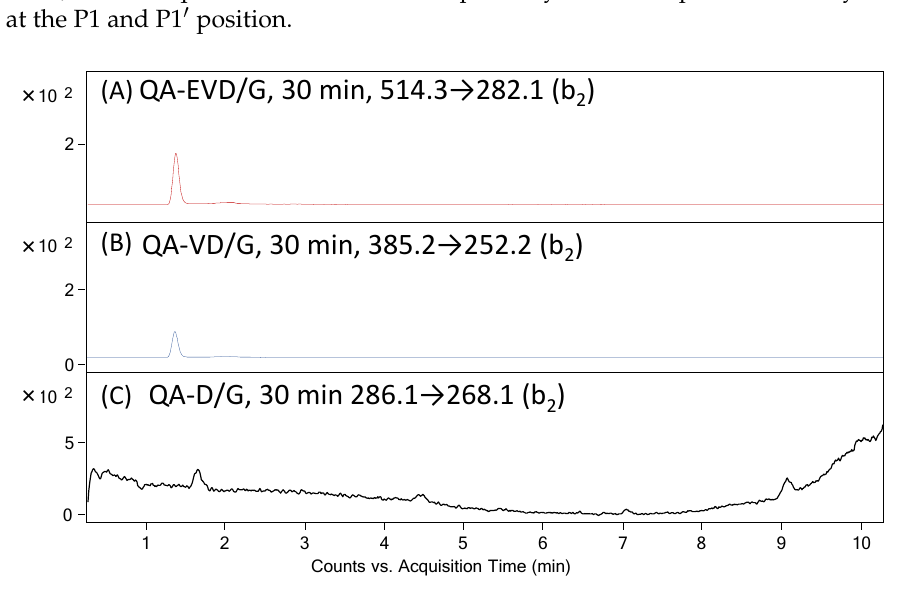
Figure 6. MRM chromatograms for ( A ) QA-EVD-OH (514.3 → 282.1), ( B ) QA-VE-OH (385.2 → 252.2) and ( C ) QA-D/G peptides investigated in supernatant after 30 min of enzymatic digestion on solid support.